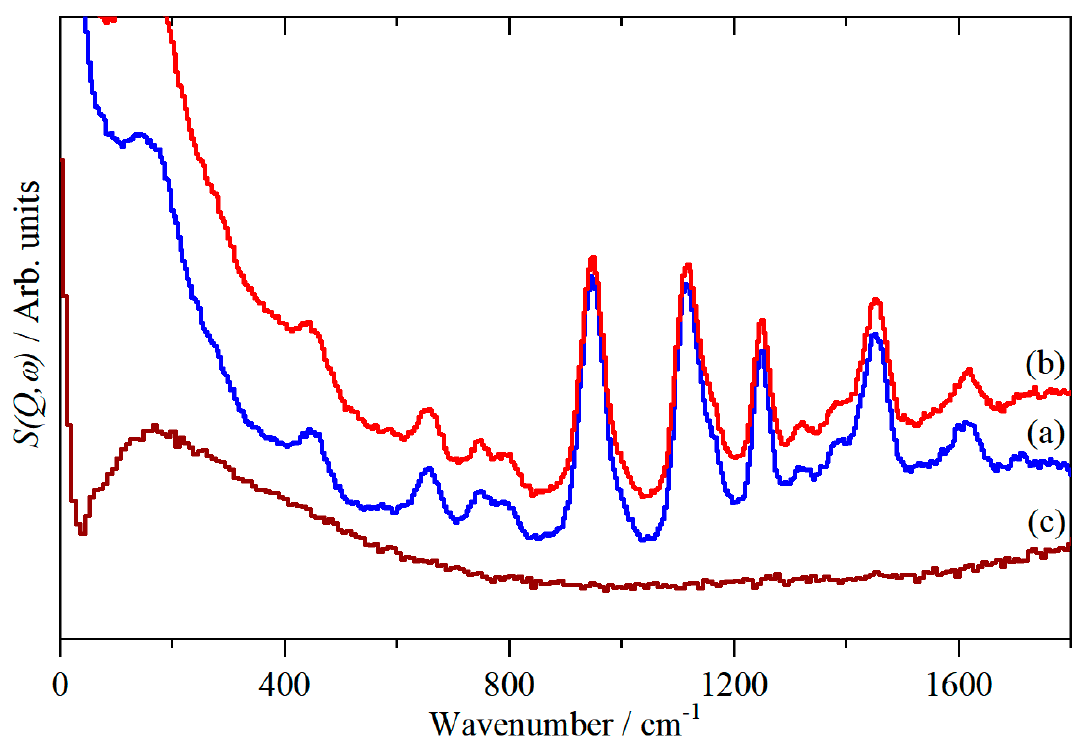
Figure 4. INS spectra at 7 K in the fingerprint region ( E i = 2000 cm − 1 ) of ( a ) clean Fe-BTC, ( b ) Fe-BTC + H 2 and ( c ) difference spectrum ((Fe-BTC + H 2 )-(clean Fe-BTC)), i.e., ( b – a ). All the spectra are plotted on the same ordinate scale, with no offsets.